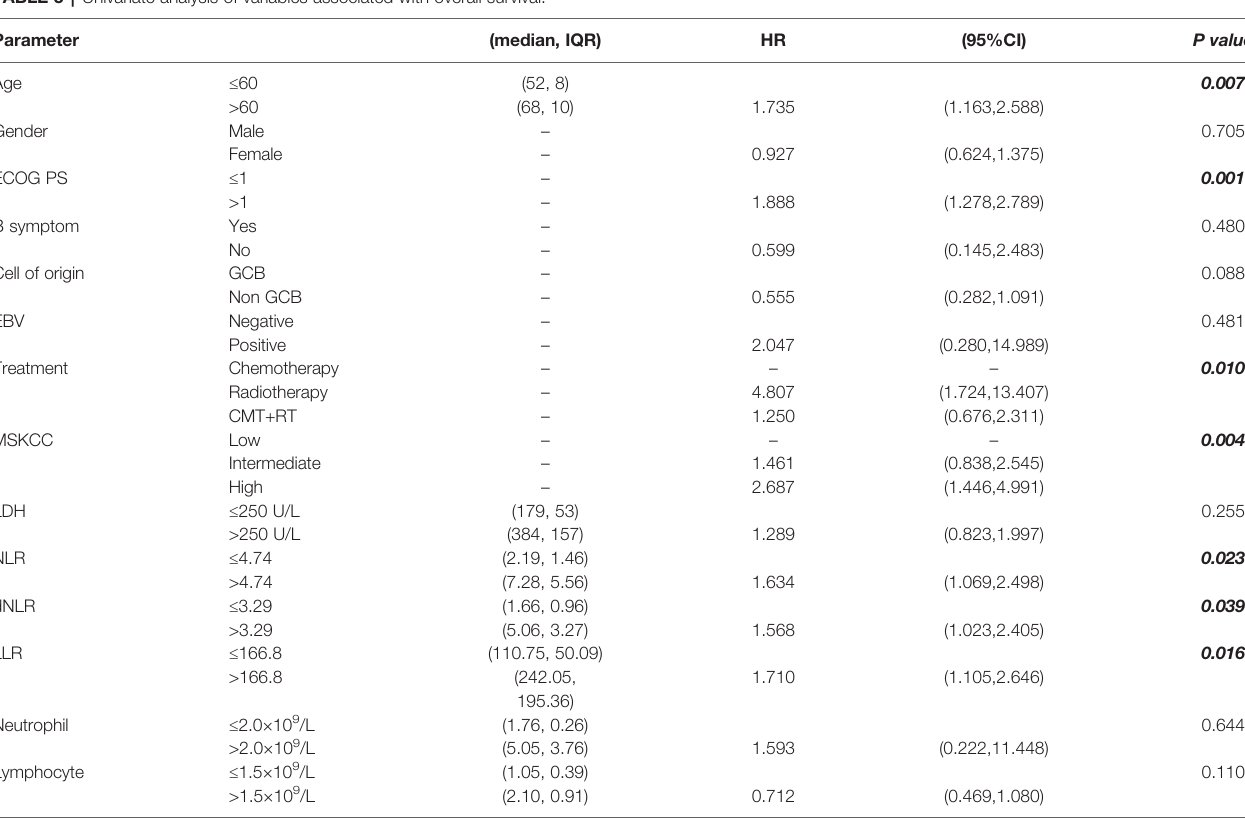
TABLE 3 | Univariate analysis of variables associated with overall survival.